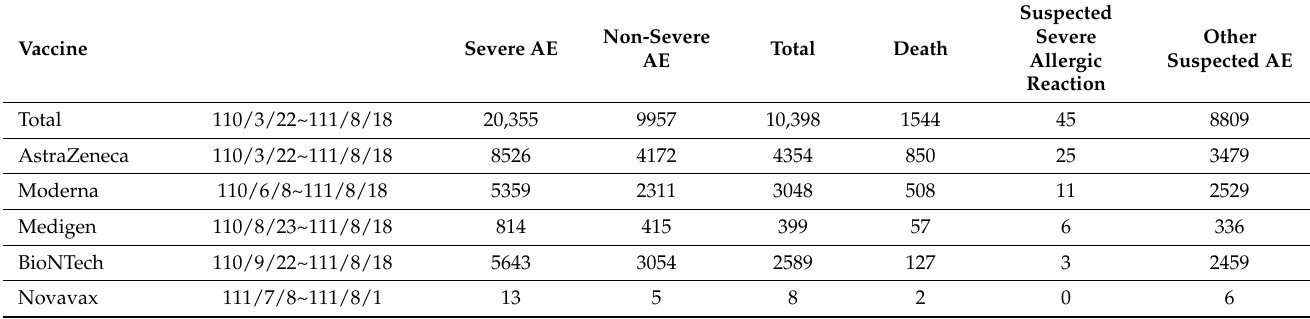
Table 1. Post-COVID 19 Vaccine Adverse Effect Report (AE = adverse